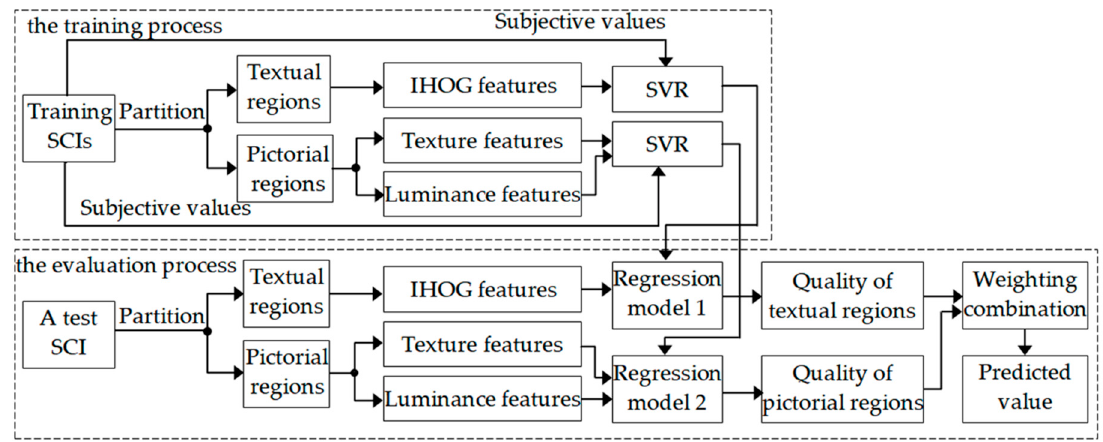
Figure 2. The framework of the proposed BSRSF method.